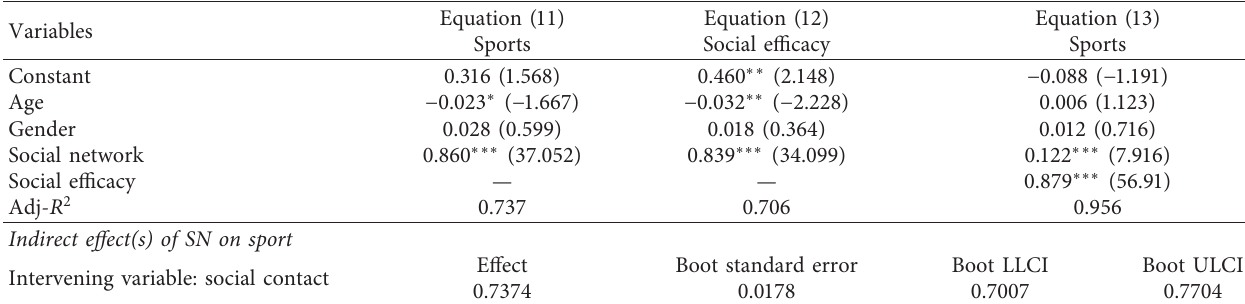
Table 3: Estimated results and significance test results of mediating effect of social